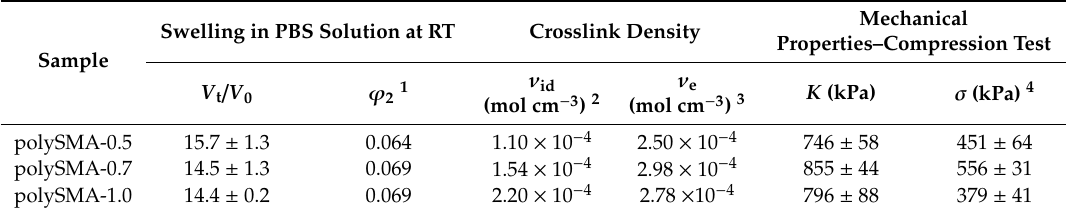
Table 2. The polySMA hydrogel characteristics: Equilibrium volume ratios in PBS solution, crosslink density and mechanical properties.